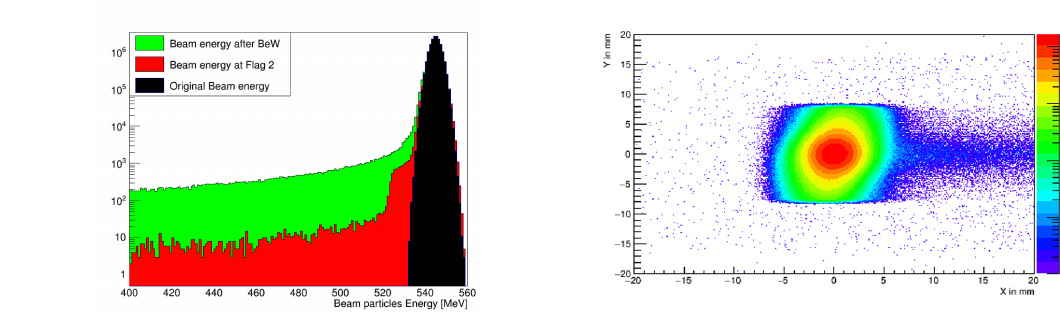
Figure 4 . Beam energy profile as seen along different sections of the beam line.